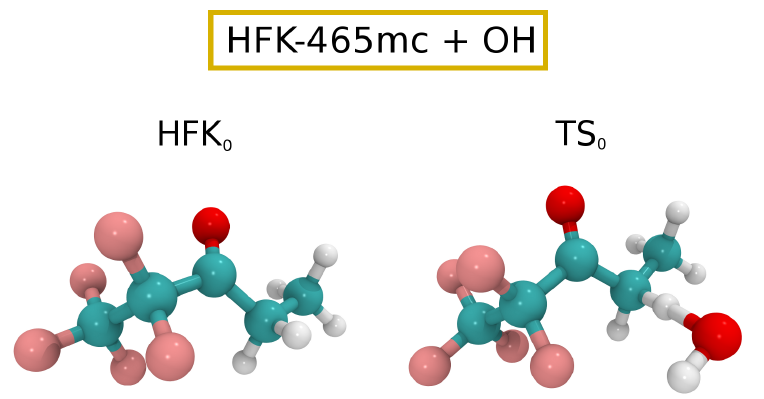
Figure 3. Ball and stick drawings for the lowest energy HFK-465mc reactant and respective TS 0 for reaction